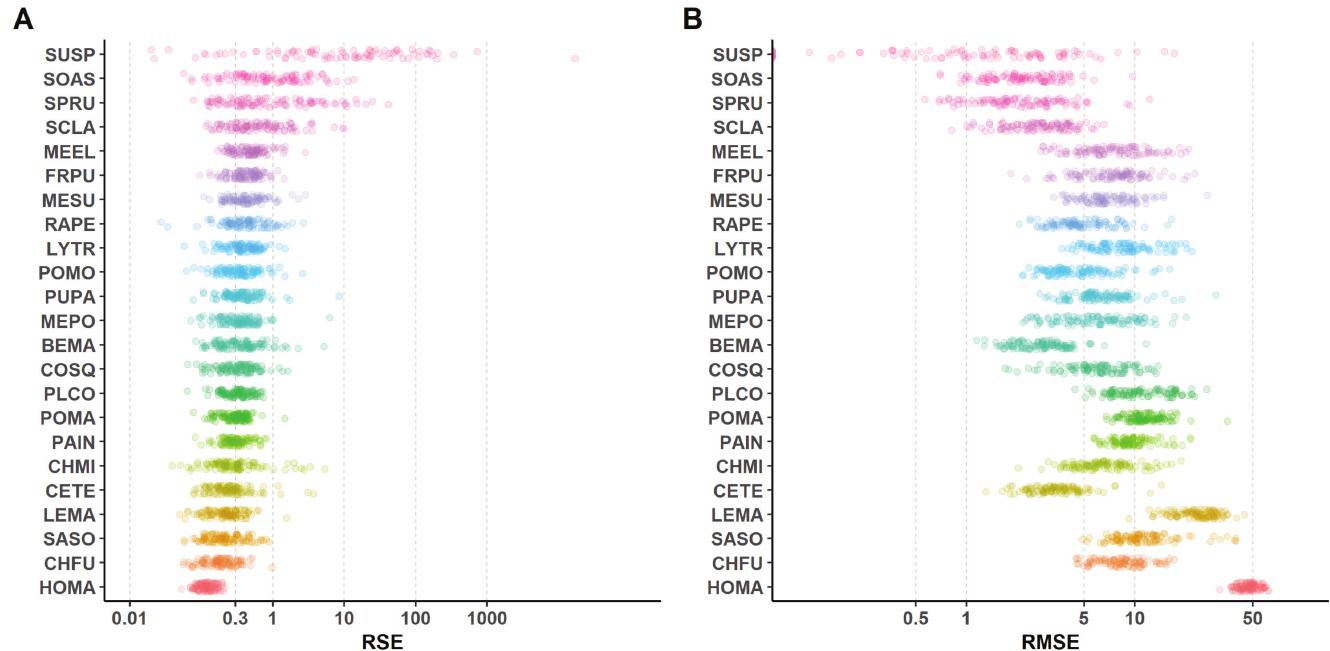
Fig 3. Prediction errors by species using a two-step Random Forest Regressor. A: Relative Squared Error distributions for 100 random choices of training/testing sets. B: Root Mean Square Error distributions for the same collection of predictors. See Table C in S1 Text for species acronyms.